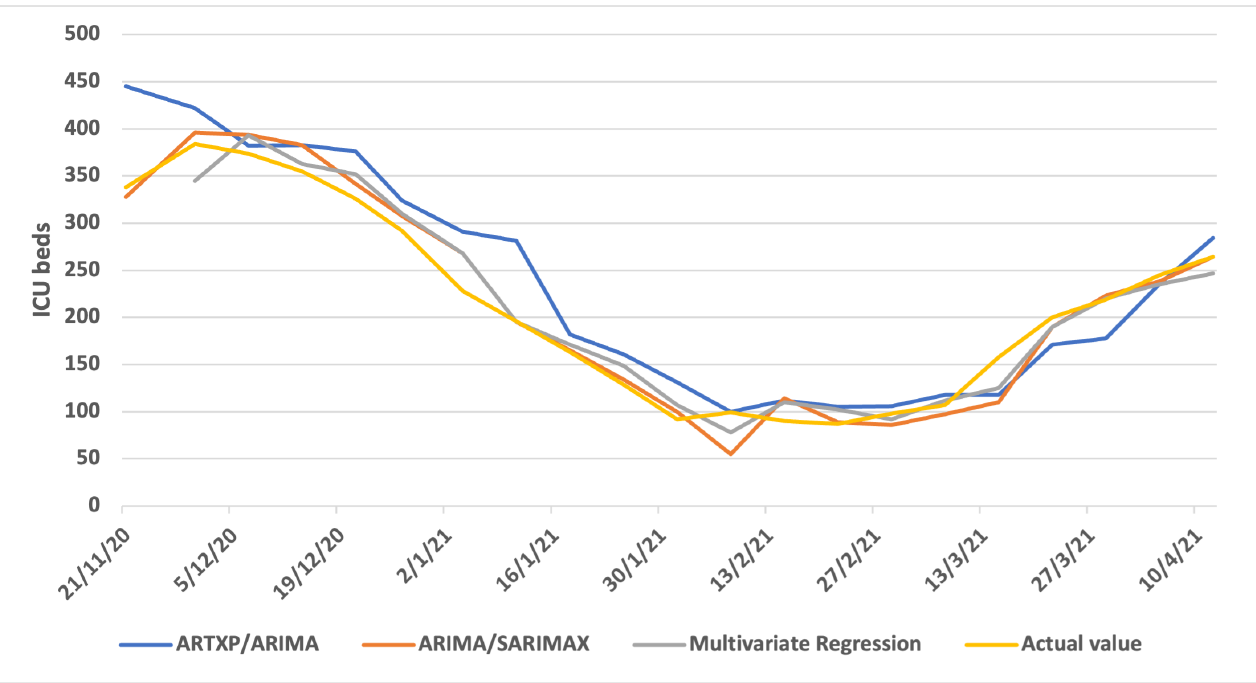
Figure A4. One week Predicted vs. Actual ICUs—Northern